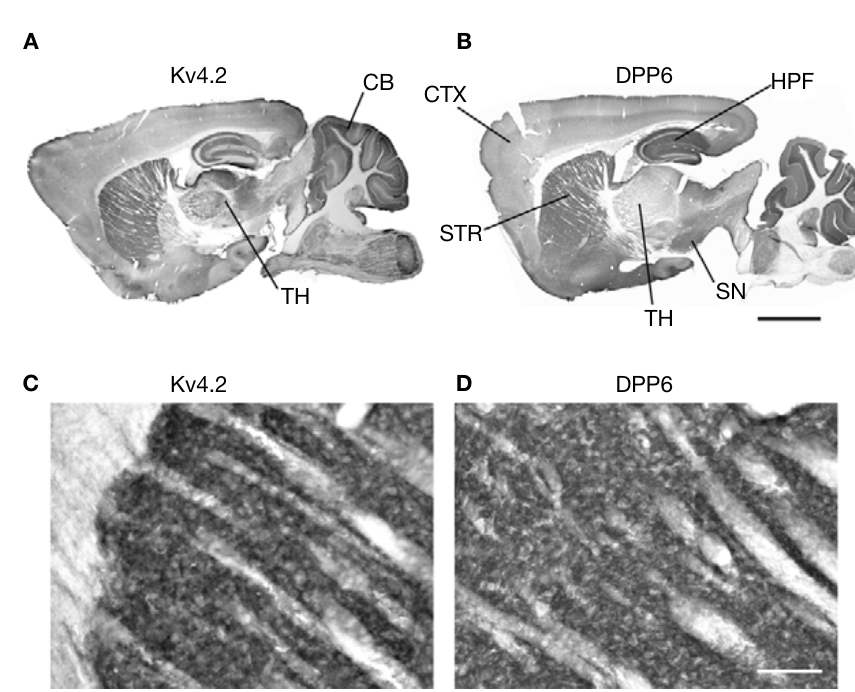
Figure 3 | DPP6 and Kv4.2 are expressed in similar structures in mouse brain. (A,B) Both Kv4.2 and DPP6 proteins are widely distributed throughout the mouse brain. The three structures most prominently labeled with Kv4.2 antibodies (A) the striatum (STR), hippocampus (HPF) and cerebellar (CB) cortex, are prominently labeled by antibodies to DPP6 (B) . (C,D) Magnifi cation of the Kv4.2 (C) and DPP6 (D) immunostaining of the striatum. As previously reported for antibodies to Kv4.2 and KChIPs (Rhodes et al., 2004) the labeling is concentrated in the neuropil. Neuronal somata are weakly labeled and are not apparent. All images are immunoperoxidase staining. Scale bar: 2 mm (A,B) ; 100 μ m (C,D)